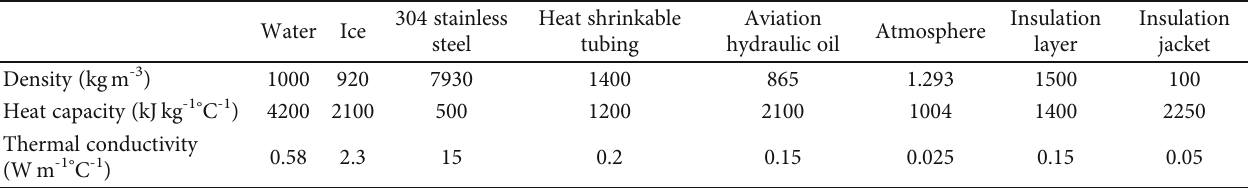
Table 2: Material parameters of the fi nite element model. The water and ice parameters were taken from Blue [56], Slack [57], Gu and Stefan [58], and Ramires et al. [59]; the 304 stainless steel parameters were taken from Cubberly et al. [60]; the atmospheric parameters were from Tsilingiris [61]; and the parameters of the other components were provided by the